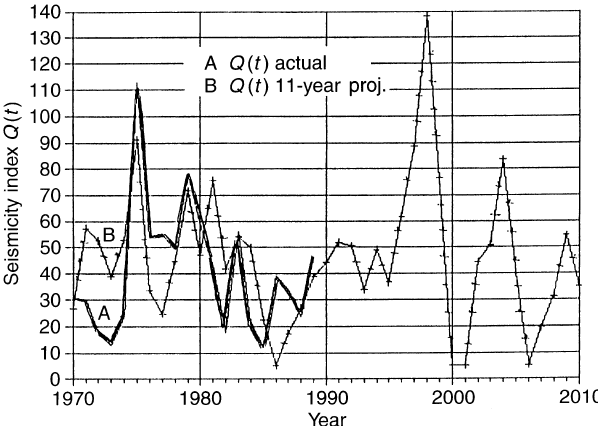
Table 4. Patterned residual of model Q